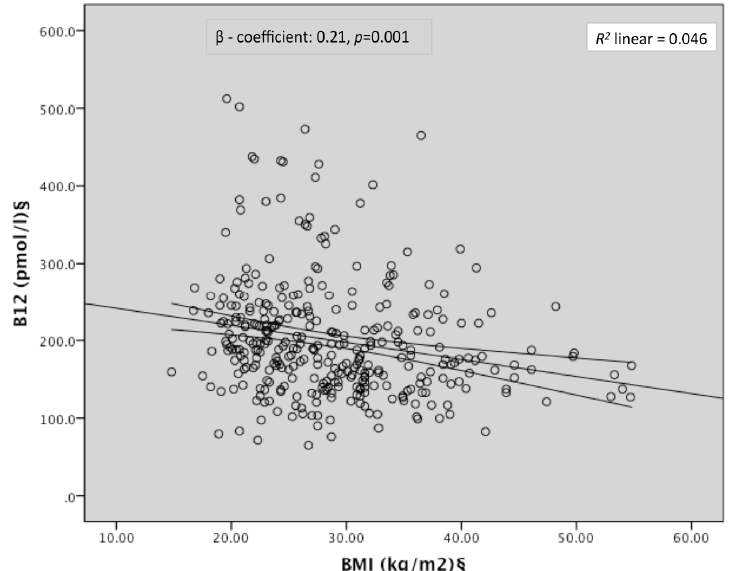
Figure 1. Scatterplot of the correlation between BMI and serum B12. § Log-transformed for statistical comparisons; Regression model included age, parity, ethnicity, smoking, gestation of bloods, folic acid supplements, and serum folate.